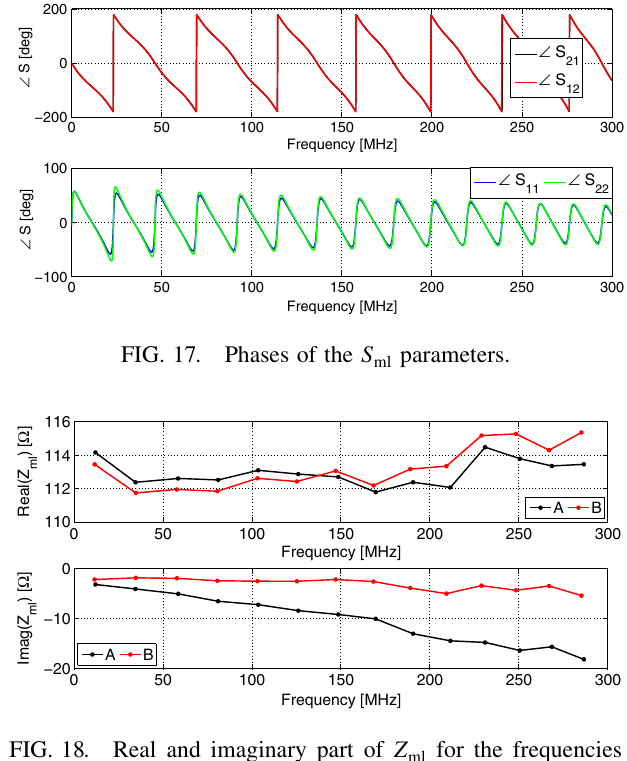
FIG. 18. Real and imaginary part of Z ml for the frequencies where (cid:1) ml L ml ¼ (cid:2) ð 2 k þ 1 Þ = 2 . Comparison between the mea- surements performed with the two different setups: (A) first setup; (B) second setup.